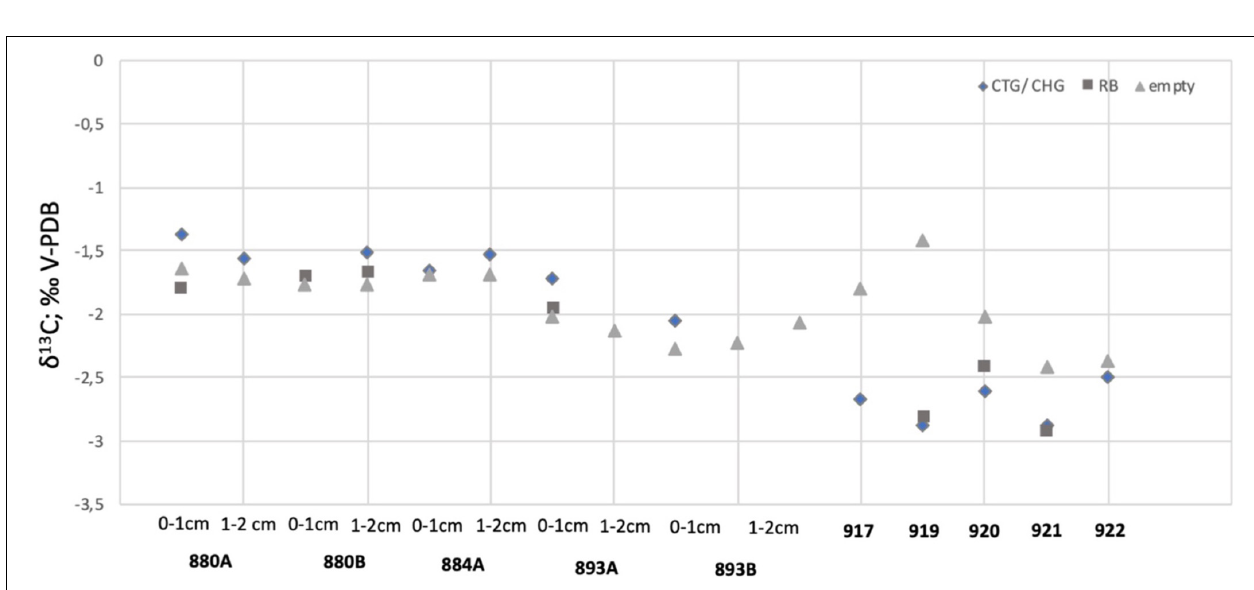
flux (Levin, 2005; Åström et al., 2020). As shown by Yao et